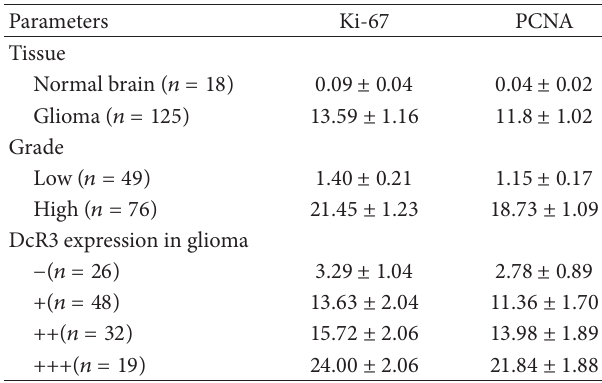
Table 2: Relationship between LIs of Ki-67, PCNA, and pathological parameters (𝑥 ± 𝑠)